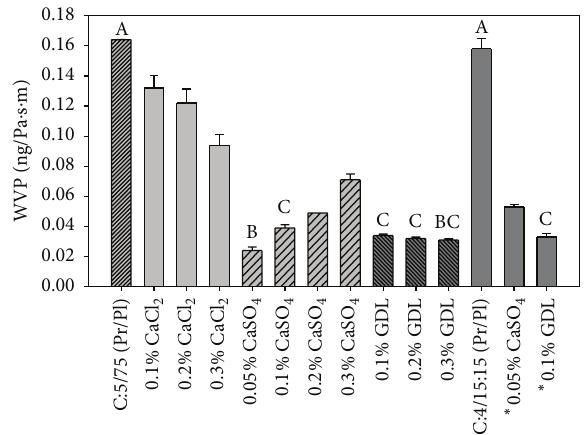
Figure 3: Water vapor permeability of unmodified and modified films prepared with formulations 5PC-75S and 4PC-15G/15S. Note: values in a column with different letters are significantly different at 𝑝 < 0.05